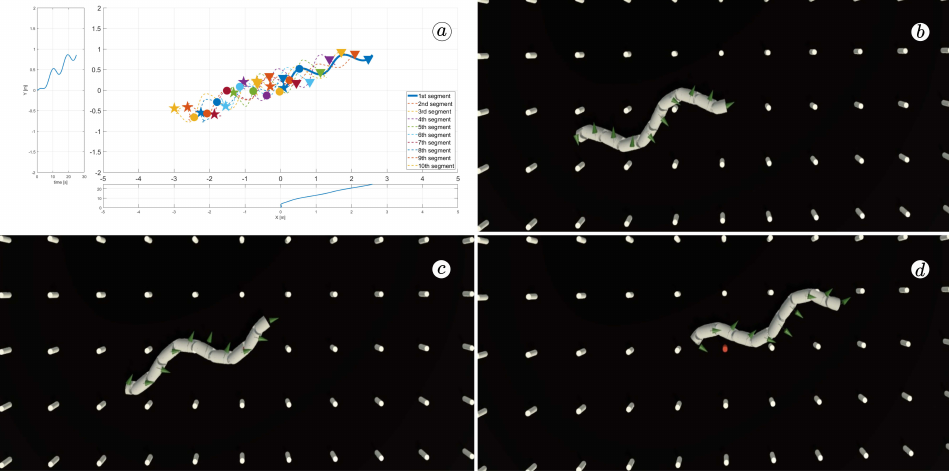
Figure 24. Trajectories of robot segments for φ i ,ref = 60 ◦ sin ( 40 ◦ t + ( i − 1 ) 60 ◦ ) ( a ) and robot configu- rations for t = 5 ( s ) ( b ), t = 10 ( s ) ( c ), and t = 24 ( s ) ( d